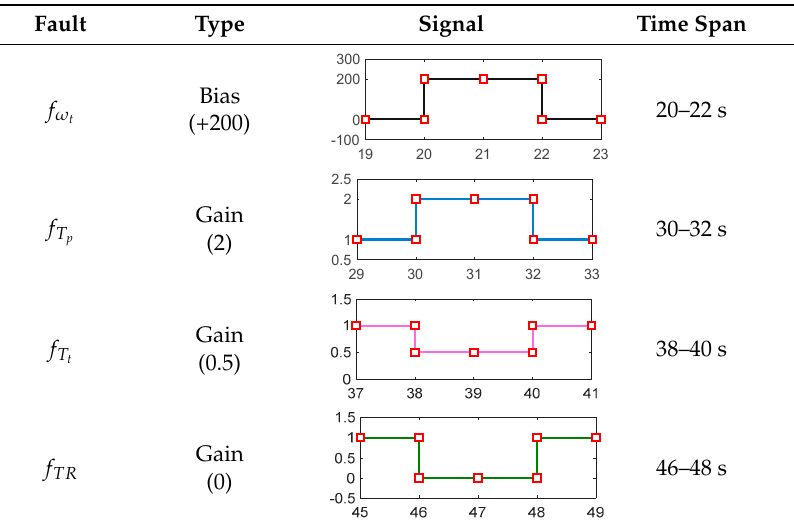
(b) Figure 9. Torque converter characteristics: ( a ) torque ratio by speed ratio; ( b ) K-factor by speed ratio. (b)(a) f ω f KF f TRt p t p Figure 10. Normal driving simulation of a vehicle with an HTC in a four-speed transmission: ( a ) gear shifting in a driving cycle; ( b ) vehicle speed in a driving cycle. Here, we only show gradual acceleration without braking. 4.2. Validation of the FDI System for the HTC 4.2.1. Fault Setting To test the FDI system, we purposely inject six faults into the system, as shown in Figure 10a. Table 5 gives the designed fault type and duration of occurrence, where the fault type and time of occurrence are also assumed. Table 5. Injected faults setting in the HTC.